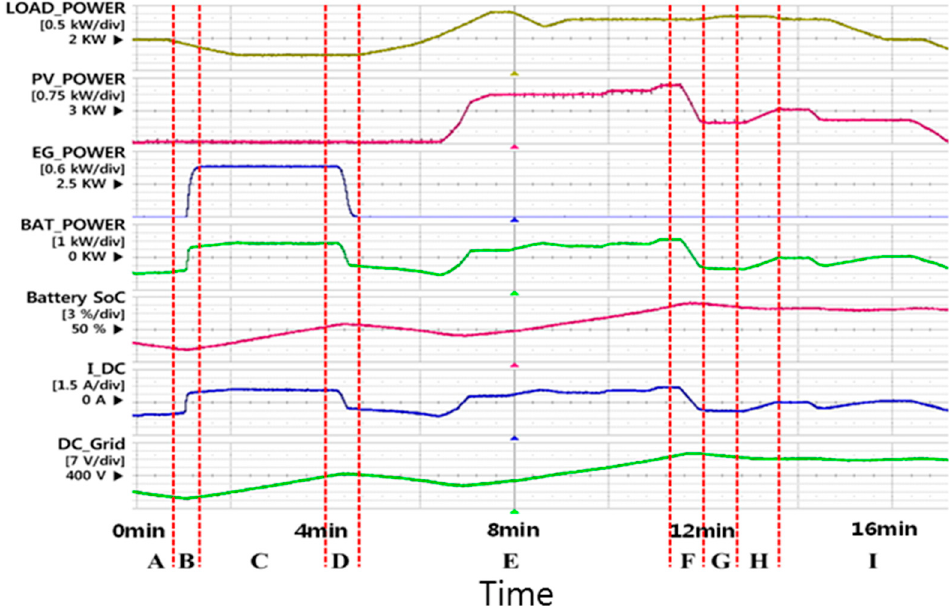
Figure 13. Experimental results with the proposed control scheme.